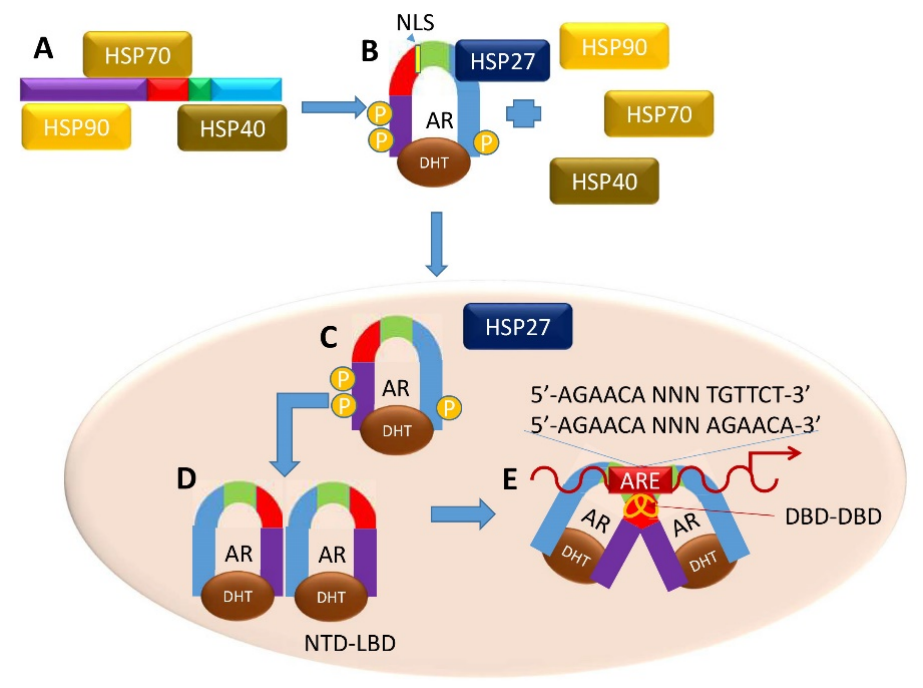
Figure 4. Canonical Genomic AR Signaling Pathway. ( A ) Upon androgen binding to AR, heat-shock proteins dissociate and ( B ) the AR forms NTD-CTD monomers. ( C ) These monomers translocate to the nucleus, and ( D ) form NTD-LBD homodimers. ( E ) Both androgen-bound homodimers ( C , D ) form a DNA-dependent DBD–DBD homodimer at AREs to enact a transcriptional program related to normal prostatic function.